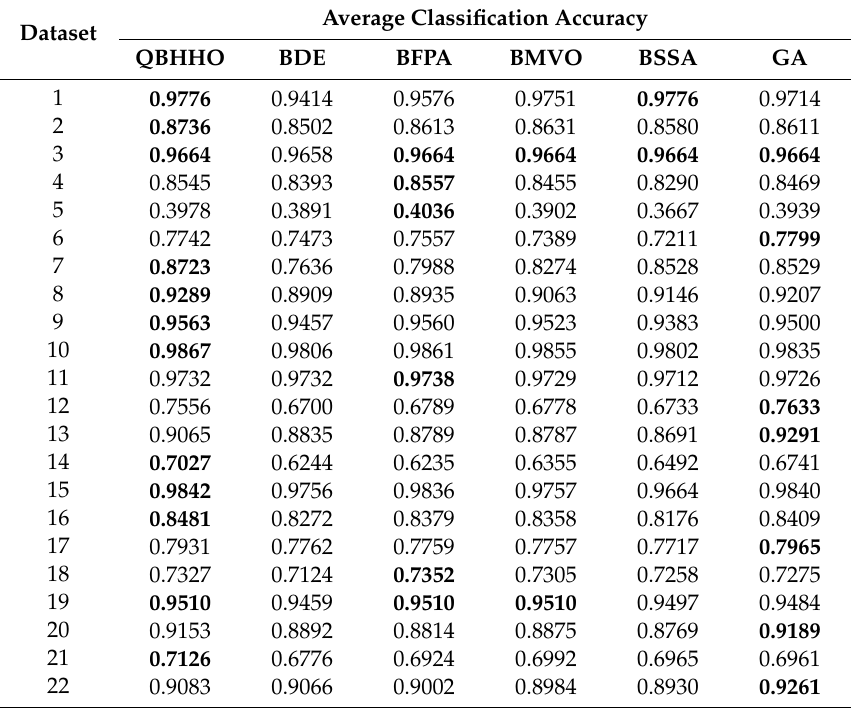
Table 13. Experimental result of the average classification accuracy of six di ff erent algorithms.